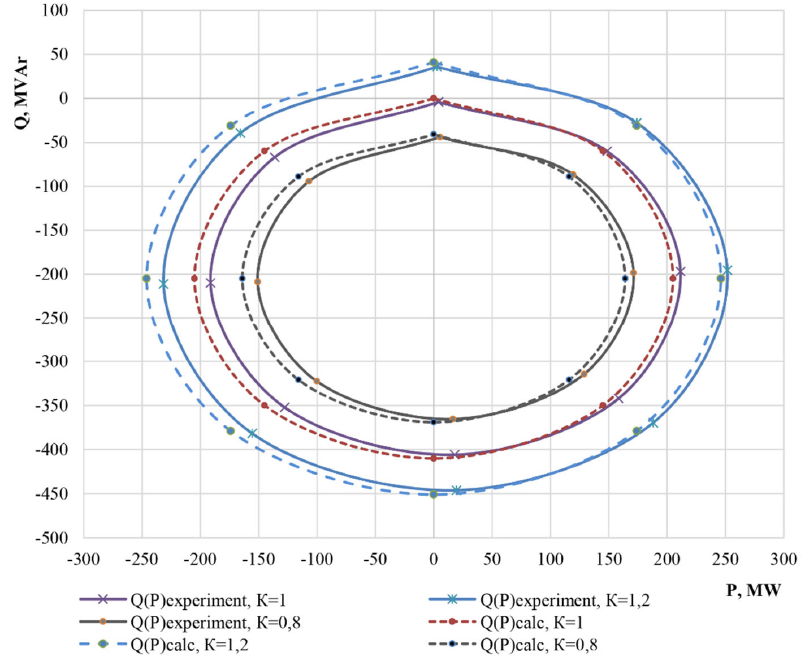
Figure 8. Circular power chart.